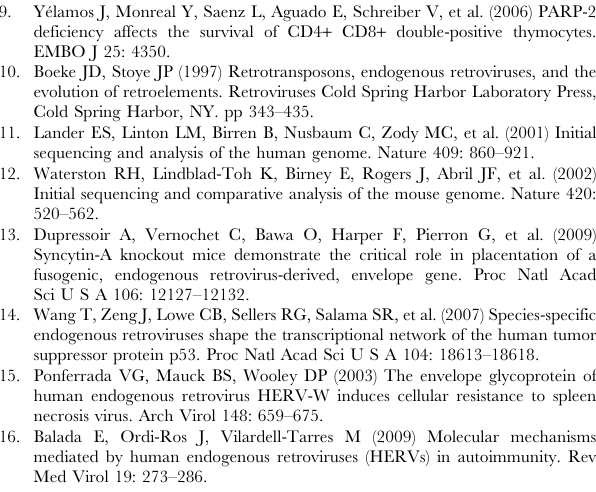
Figure S8 Effects of pifithrin-alpha (PFT- a ) treatment on GTX-induced BC expression in NIH/3T3 cells. NIH/ 3T3 cells were treated with ETOP or MMS in combination with indicated concentrations of PFT- a . Cells were harvested after 24 h and BC expression was analyzed by quantitative PCR. Data were Table S1 Step-wise criterion in selecting up-regulated genes. Table S2 Step-wise criterion in selecting down-regulated genes. Table S3 Raw data and detailed scoring rule of up- regulated